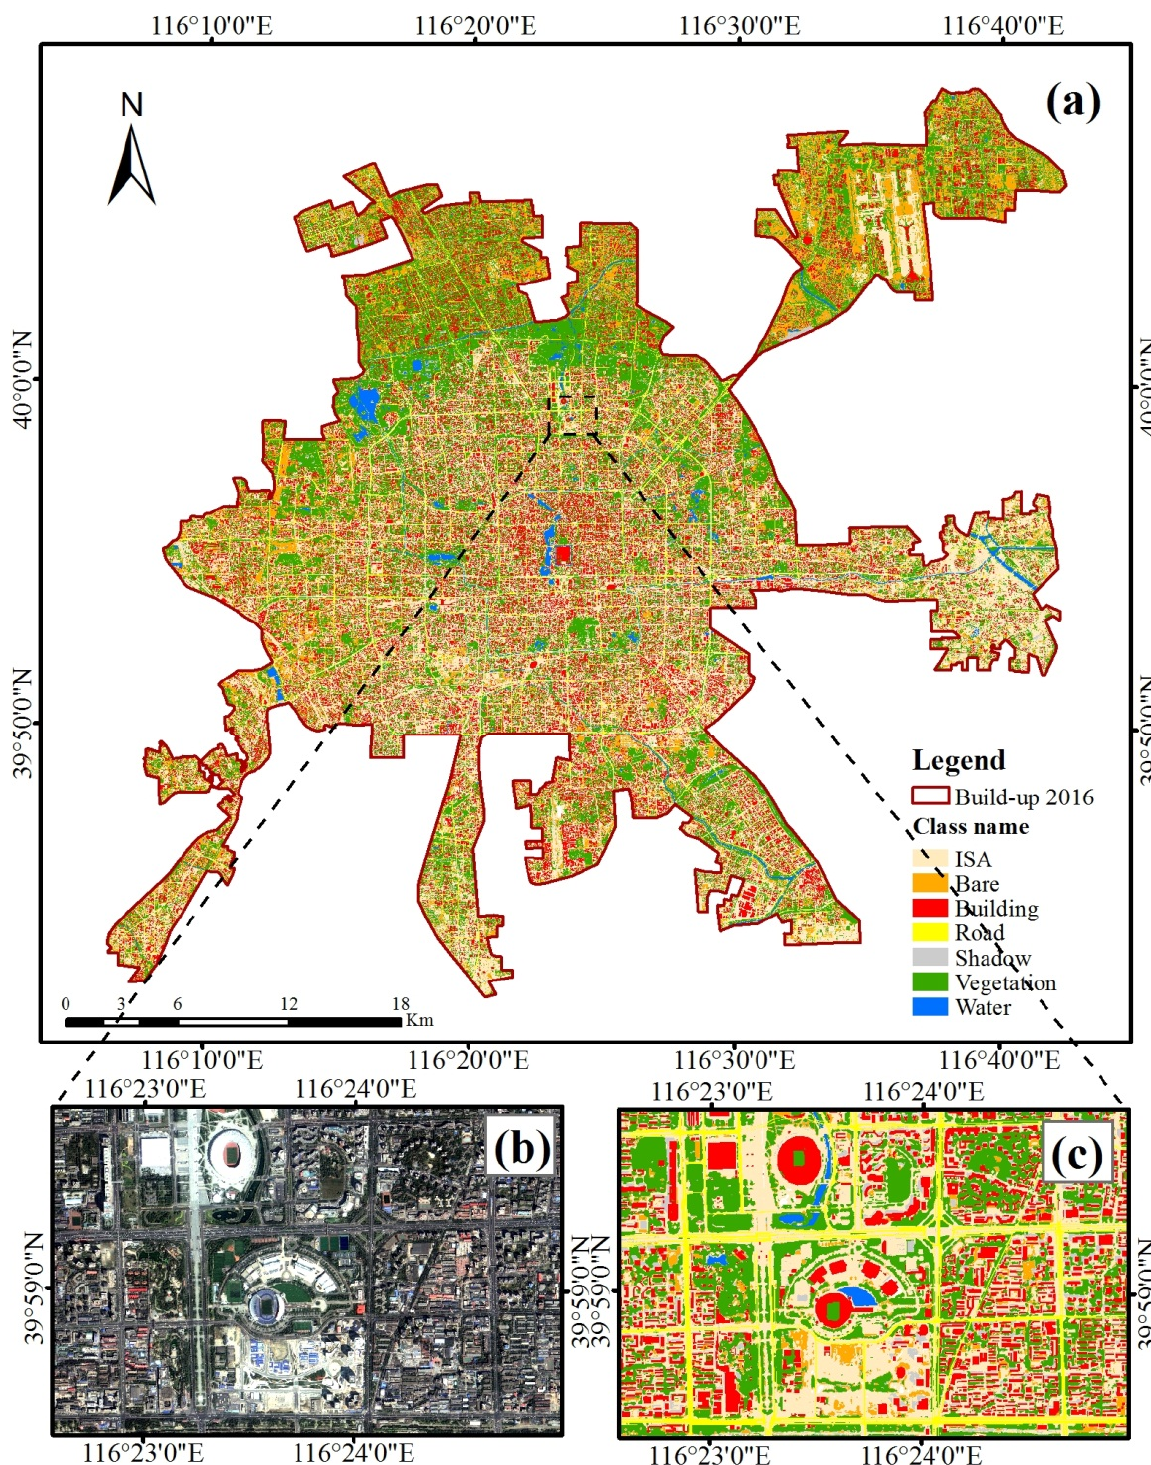
Figure 6. (a) Land-cover mapping of the BUA in Beijing in 2016; (b) detailed comparison of GaoFen- Figure 6. ( a ) Land-cover mapping of the BUA in Beijing in 2016; ( b ) detailed comparison of GaoFen-1 1 imagery; and (c) classification results. imagery; and ( c ) classification